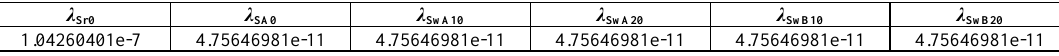
Table 1. Baseline failure rates for components of the example mesh